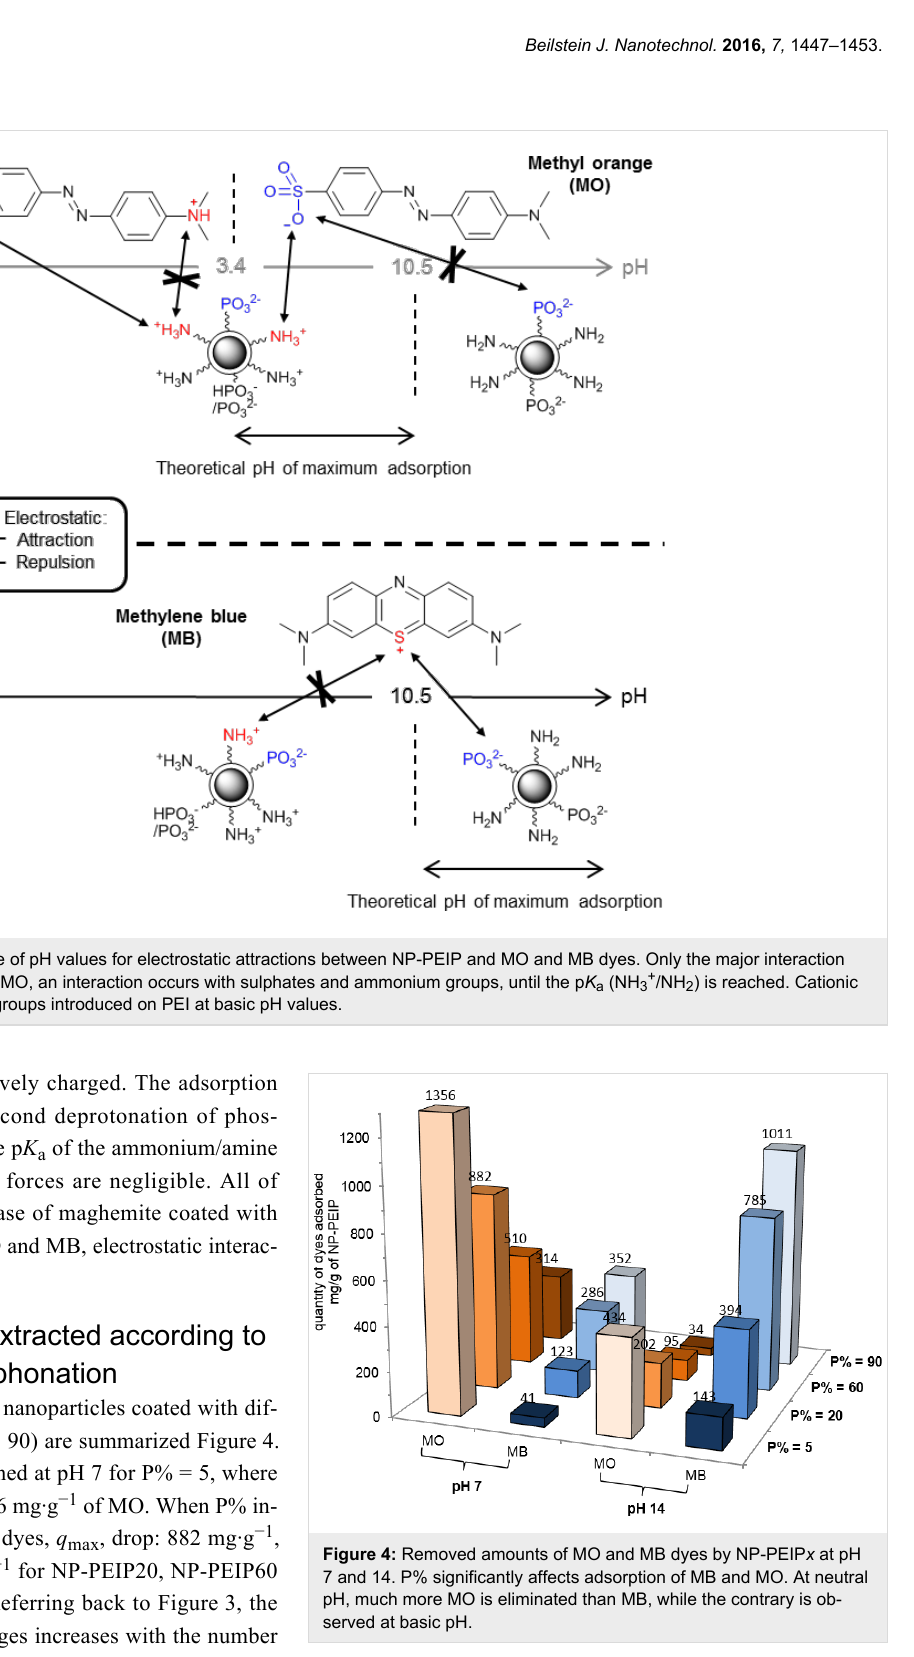
of MB. The value of q max is increased to the